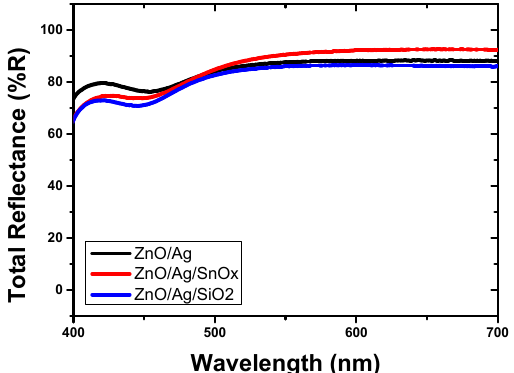
Figure 3. Total reflectance according to the back structure on the graphite sheet.